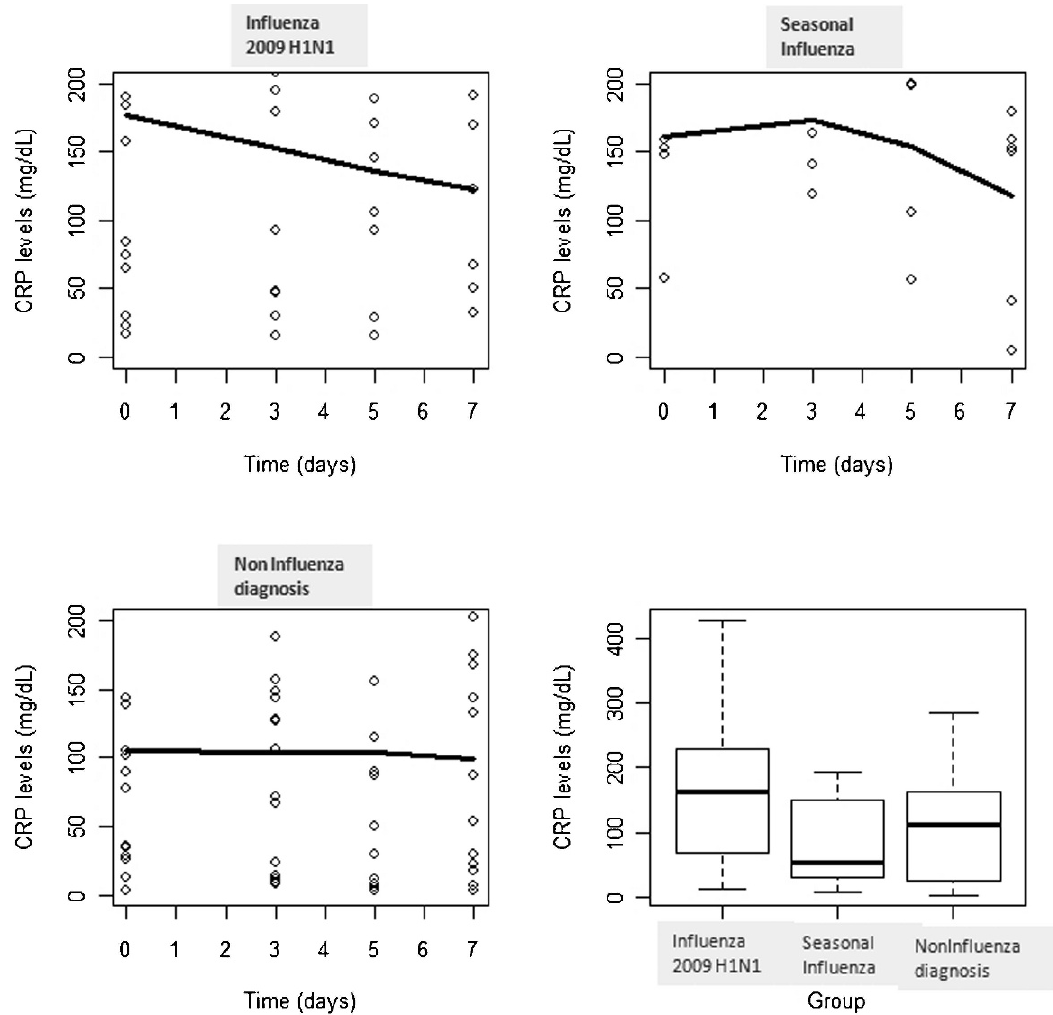
Figure 3 - The circulating levels of CRP during the first seven days of follow-up in the three studied